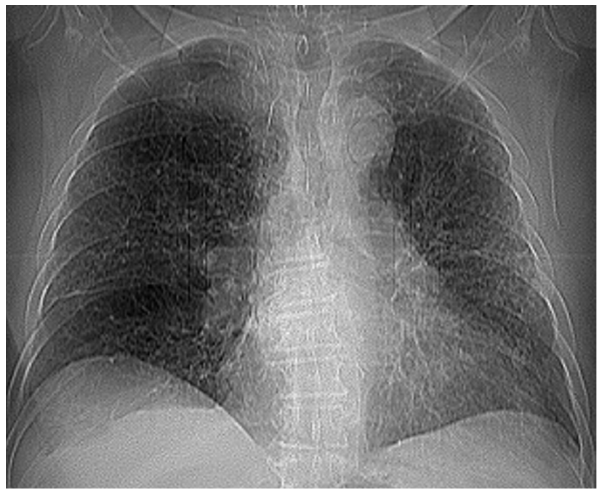
Figure 2. The selection of the portion of interest of the lungs of patient MT.